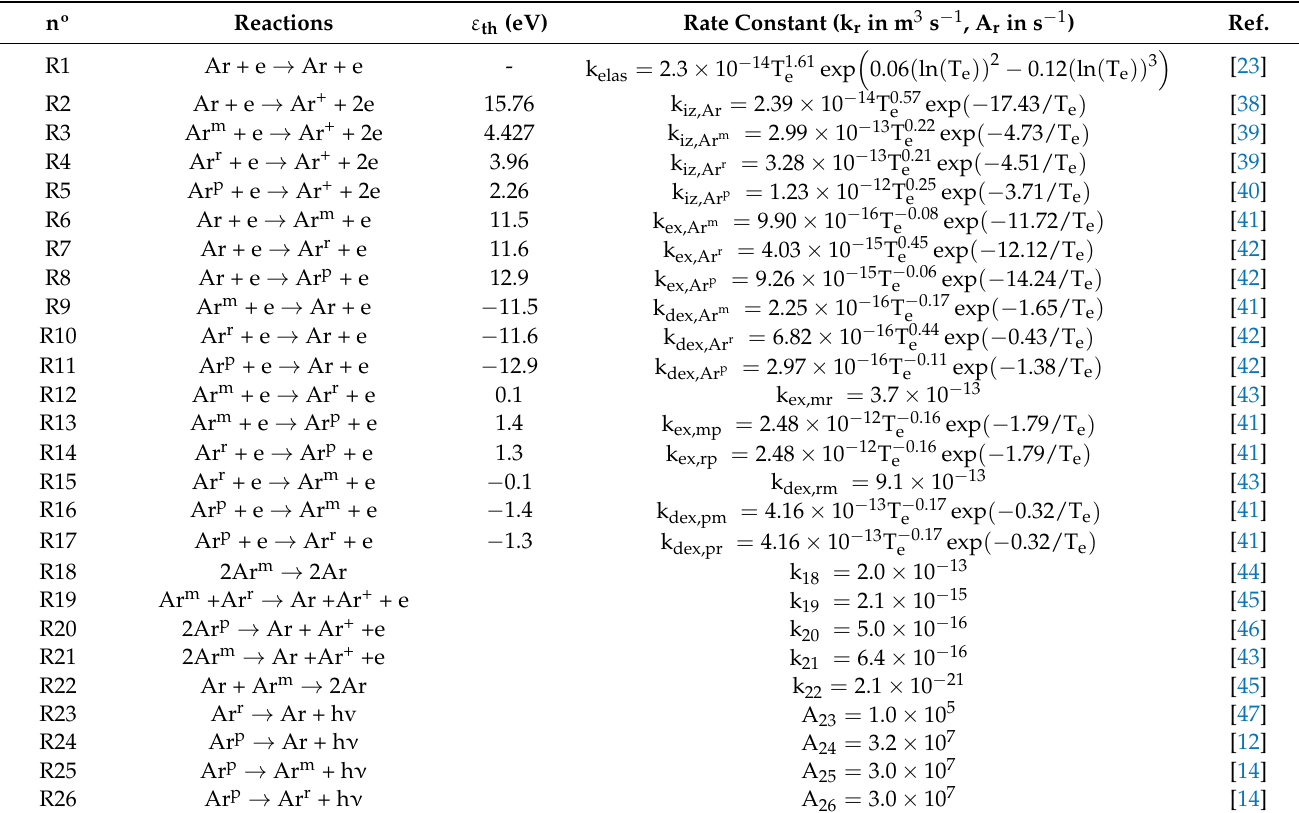
Table 1. Reactions and corresponding rate constants of the global model. The superscripts r and m denote resonance and metastable levels of the 4s excited state, respectively, and the subscript p denotes the 4p excited state. The electron temperature is given in